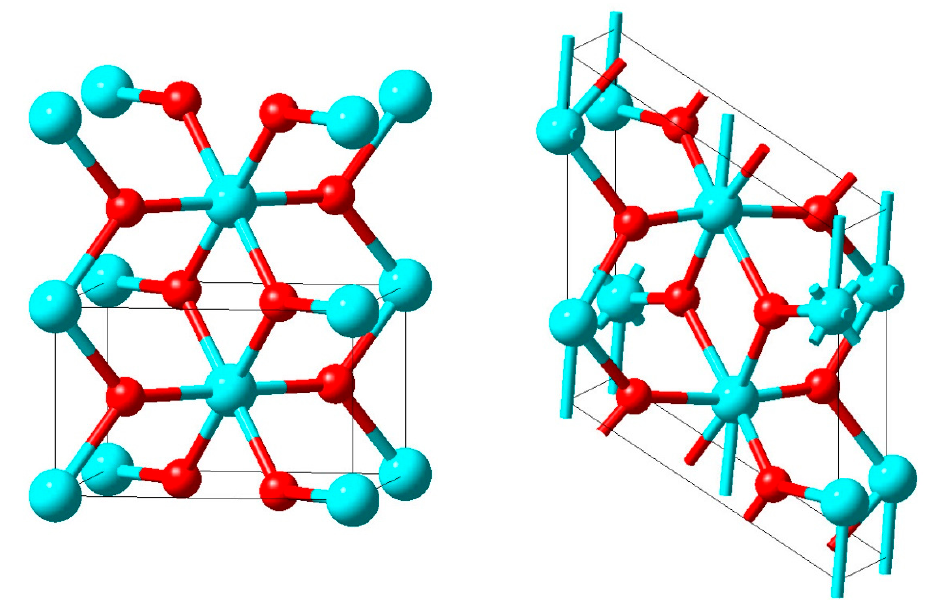
Figure 16. High-temperature rutile structure ( left ) and low-temperature M 1 structure ( right ) of VO 2 . Figure 16. High ‐ temperature rutile structure ( left ) and low ‐ temperature M Vanadium and oxygen atoms are given in cyan and red, Vanadium and oxygen atoms are given in cyan and red, respectively.